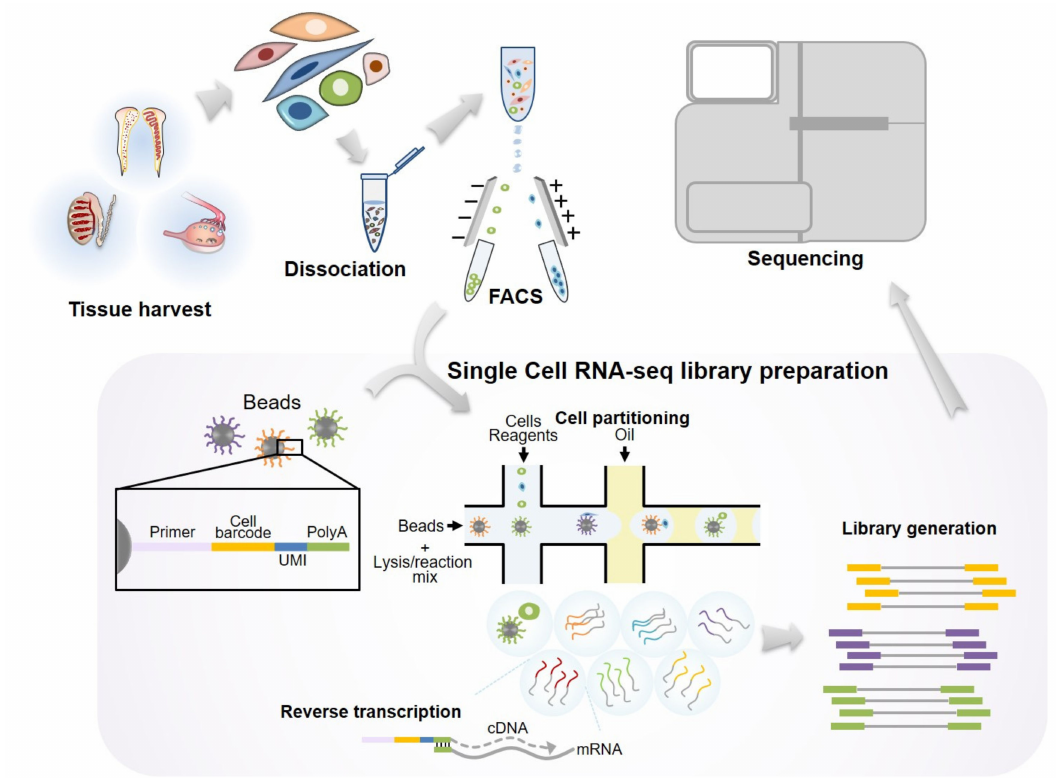
Figure 1. Schematic illustration showing the procedure of scRNA-seq in gonadal tissues. Reproductive tissues are isolated and enzymatically dissociated. Highly pure single cell populations are obtained by conventional cell sorting methods such as fluorescence-activated cell sorting (FACS) or magnetic-activated cell sorting (MACS). Uniquely barcoded beads are required for microfluid-based scRNA-seq. Technically, one cell is interacted with a bead, and subsequently the cells are subjected to cell lysis for the preparation of mRNAs. The isolated mRNAs are used for reverse transcription. Finally, scRNA-seq libraries containing bead-specific oligo sequences and unique molecular identifier (UMI) are